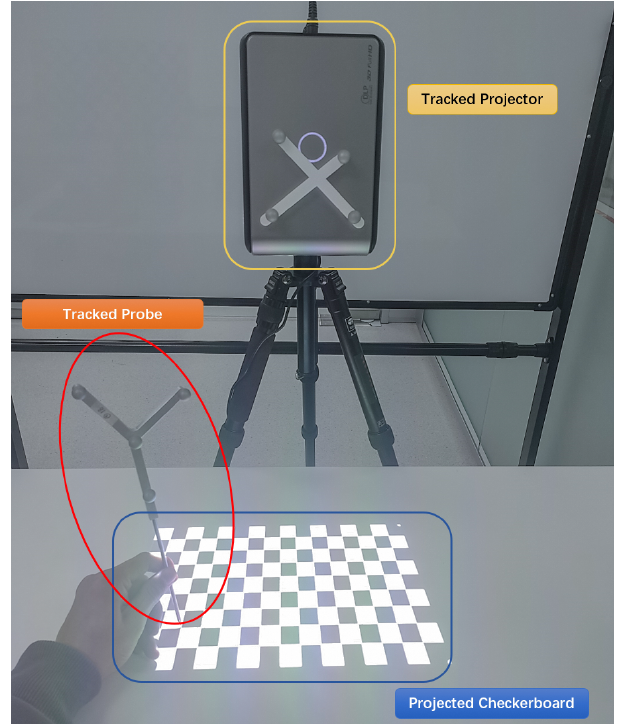
Figure 6. Obtain the spatial position of the projection